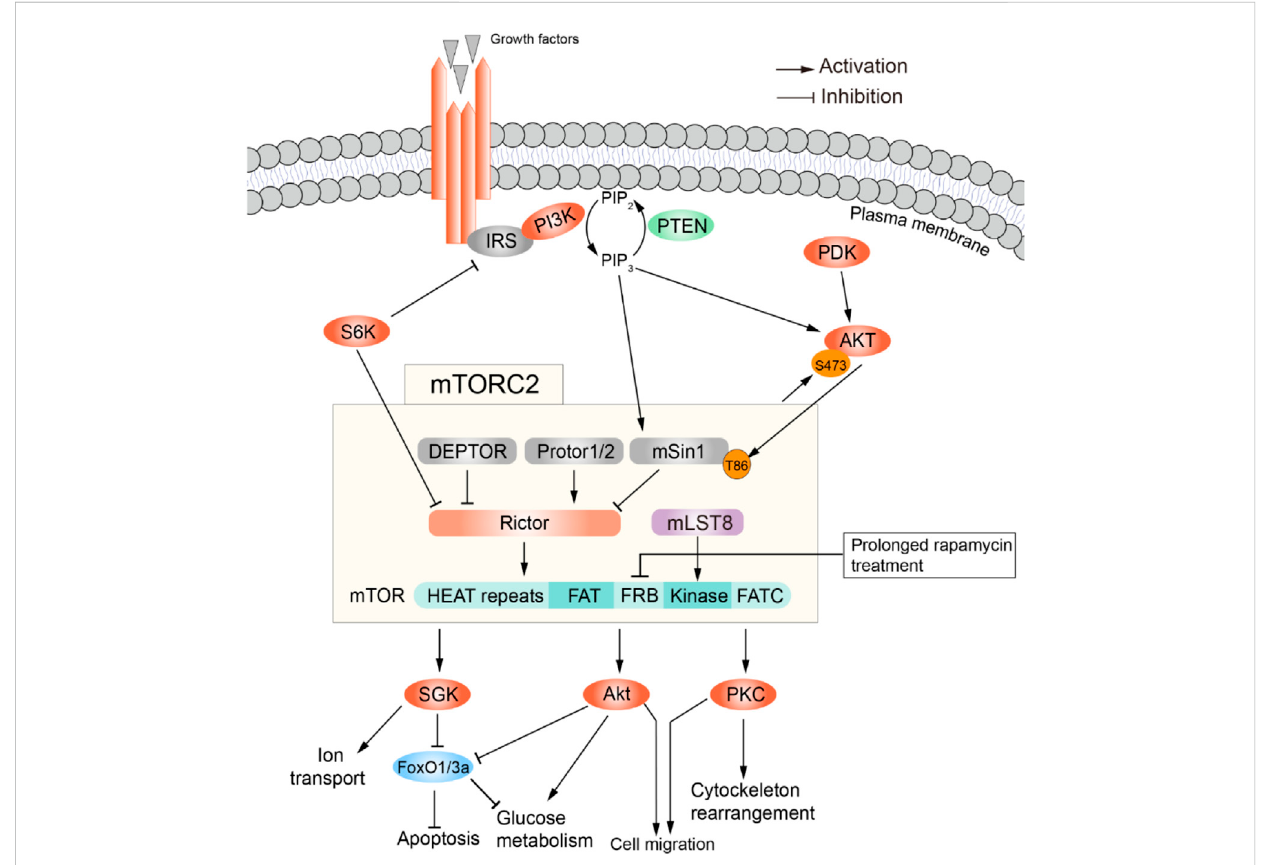
FIGURE 2 Summary of signaling through mTOR complex 2. Activators (top) and effectors (bottom) of mTORC2. Adapted from (Wei et al., 2019), available via a CC license http://creativecommons.org/licenses/by/4.0/.